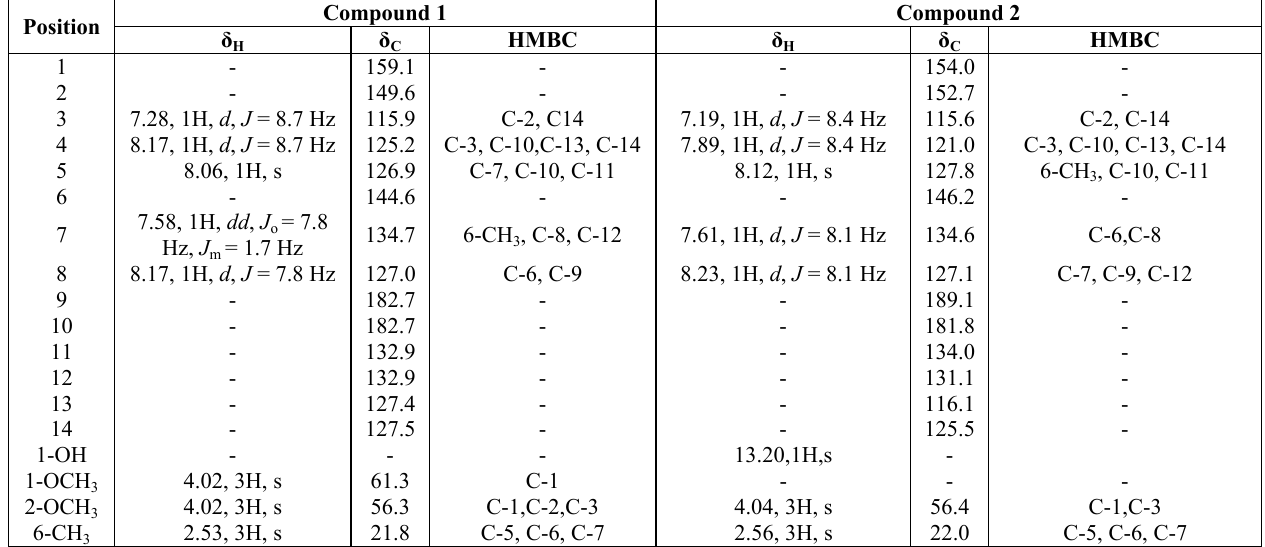
Table 1. 1 H- (300 MHz) and 13 C- (75.5 MHz) NMR Data of Compounds 1 and 2 in CDCl